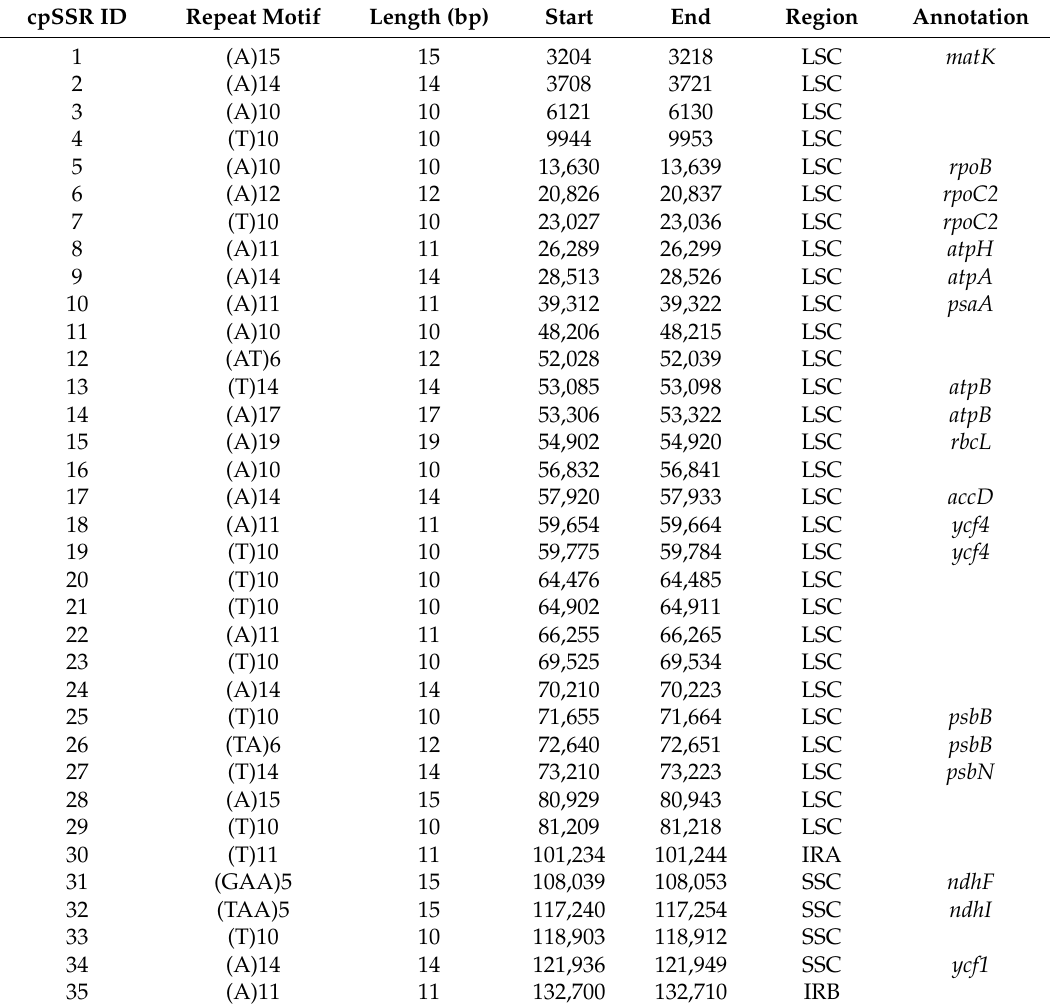
Table 5. Simple sequence repeats in the A. annua chloroplast